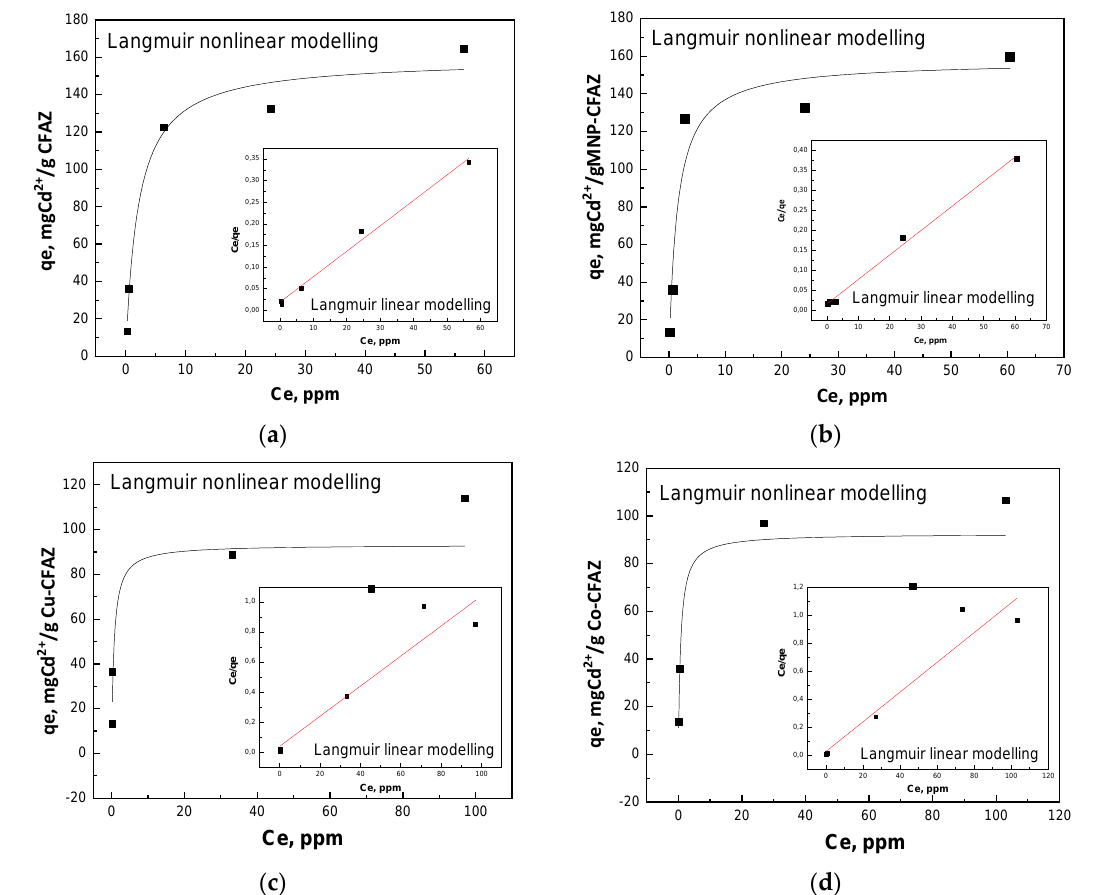
Figure 7. Experimental isotherms and Langmuir linear and nonlinear fit for Cd 2+ -ions adsorption onto nonmodified and modified CFAZ: ( a ) CFAZ; ( b ) MNP-CFAZ; ( c ) Cu-CFAZ; ( d ) Co-CFAZ.